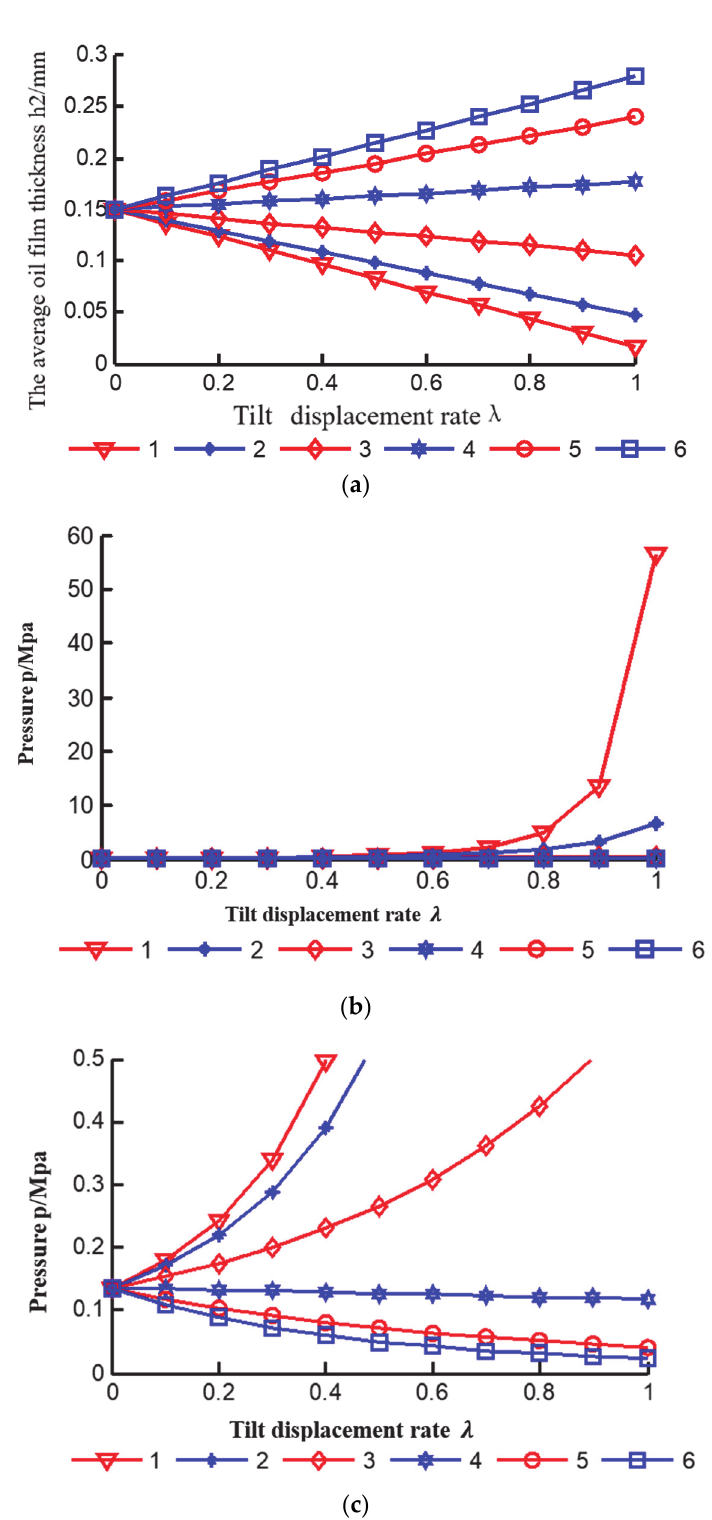
Figure 10. Influence of tilt displacement rate on pressure of oil pad cavity and average thickness of the outer circular sealing edge of oil pad. ( a ) Effect on the average oil film thickness of the outer arc sealing edge of each oil pad; ( b ) Effect on the pressure in each oil chamber; ( c ) Local magnification of effect on the pressure of each oil chamber of the oil pad.